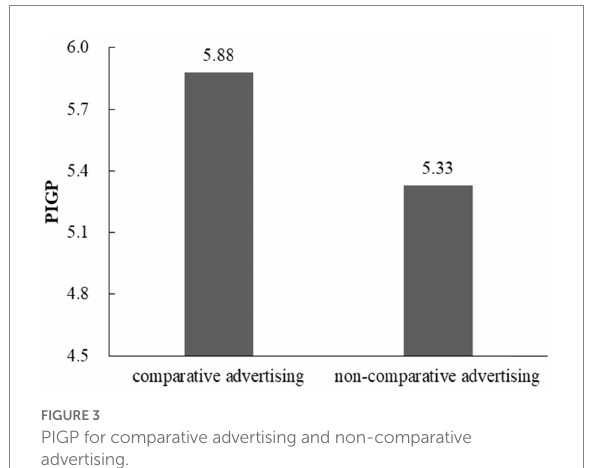
FIGURE 3 PIGP for comparative advertising and non-comparative